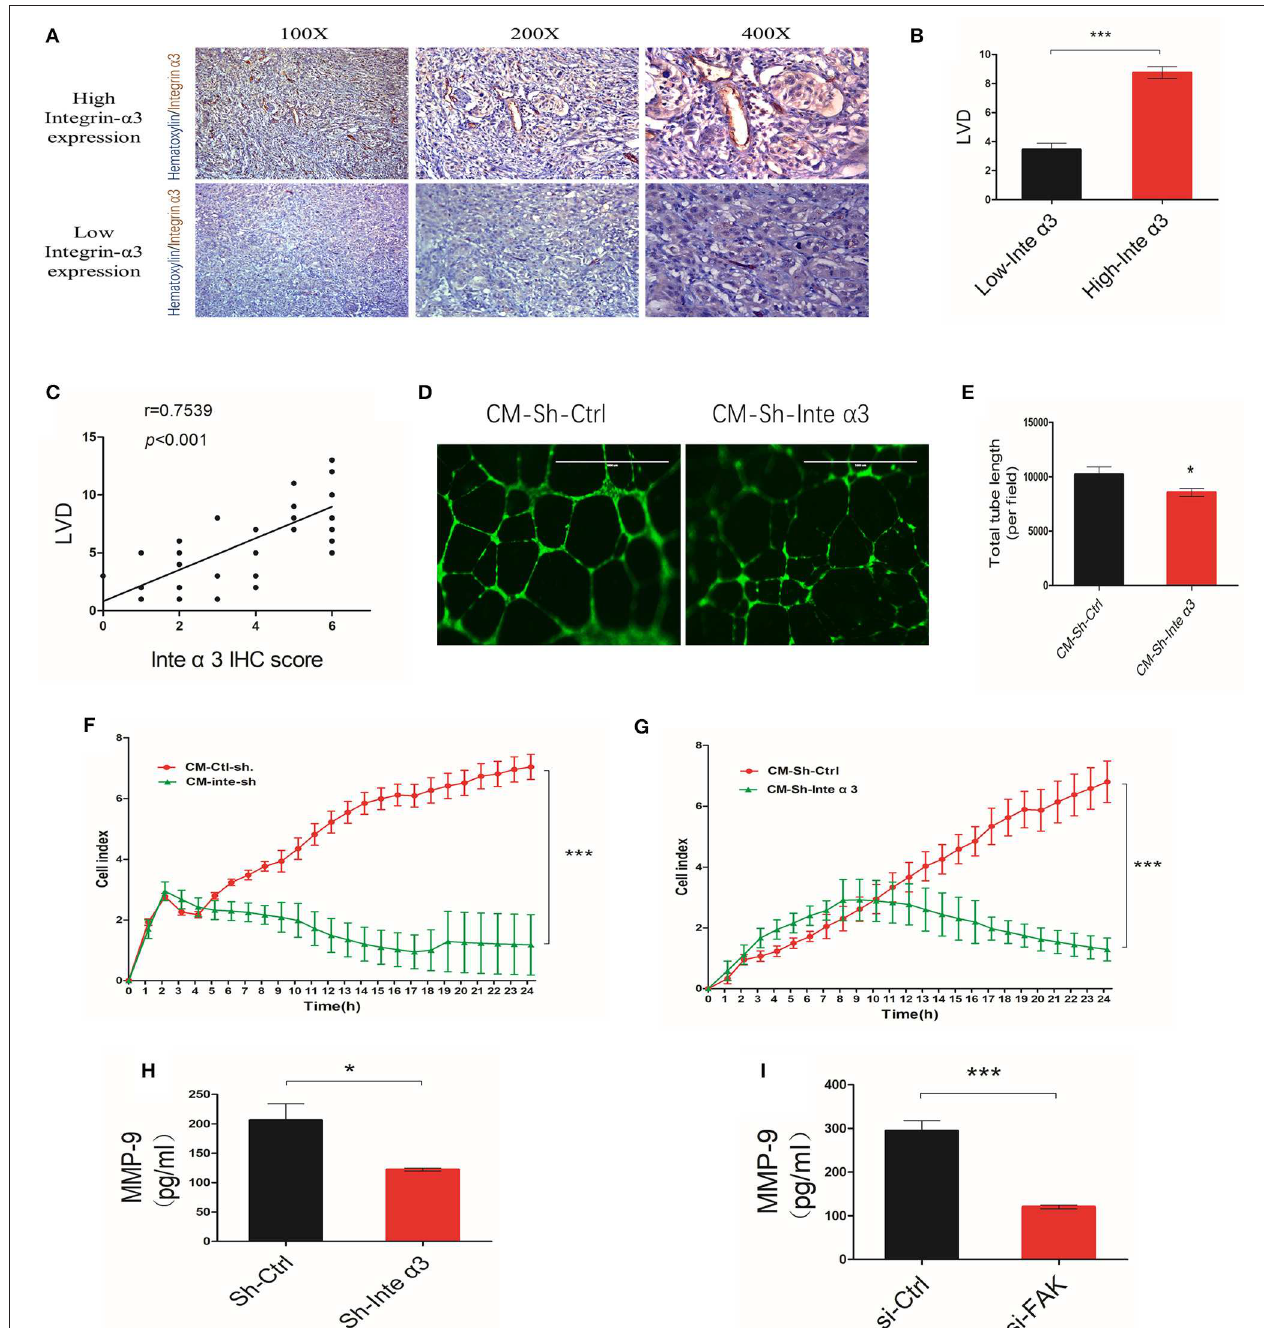
FIGURE 7 | Integrin α 3 promotes angiogenesis by secreting metalloproteinase-9 (MMP-9) in vitro . (A,B) Immunohistochemistry (IHC) staining and corresponding quantification of CD34 in the high/low integrin α 3 expression groups in cervical cancer (CC) tissue. Original magnification: × 100, × 200, and × 400. (C) Correlation of IHC score and microvascular density. The correlation coefficient is shown in the panel. (D) The human umbilical vein endothelial cell (HUVEC) tube formation assay was applied to explore the effect of integrin α 3 on angiogenesis. (E) Quantification of the total tube length per field is shown in (D) . (F,G) Real-time migration/invasion monitoring was used for the detection of migration and invasion of HUVECs treated with the cell culture medium from the Sh-Ctrl and Sh-Inte α 3 groups. (H,I) ELISA for MMP-9 was performed after knocking down integrin α 3 and focal adhesion kinase (FAK). All experiments were repeated thrice with consistent results, and the representative images are shown. * P < 0.05 vs. control group; *** P < 0.001.